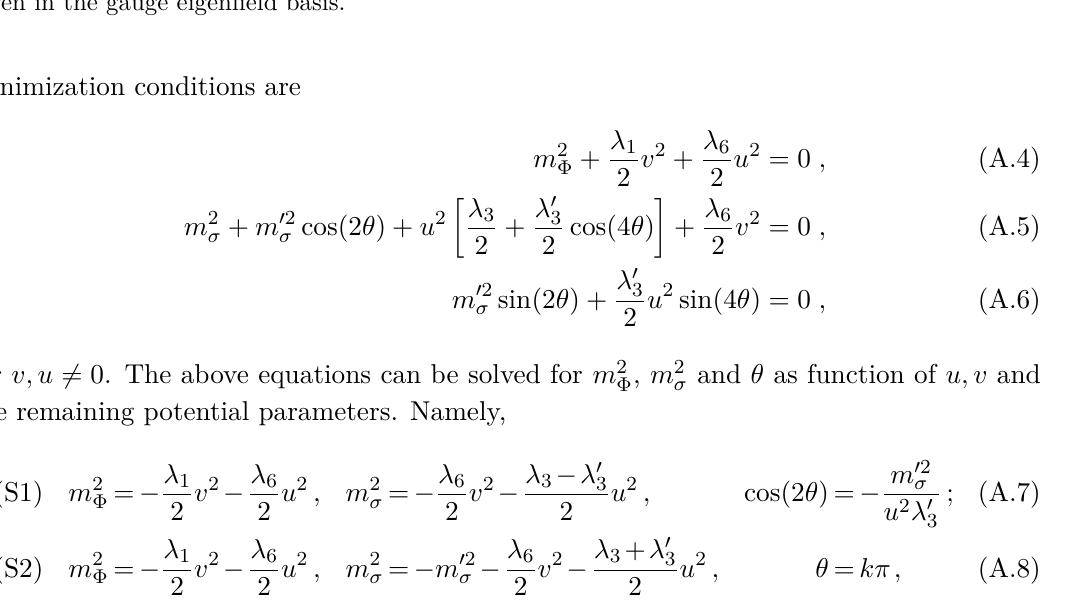
Figure 8 . Scotogenic loop with scalar mass eigenstate basis, equivalent to the ones of figure 3 given in the gauge eigenfield